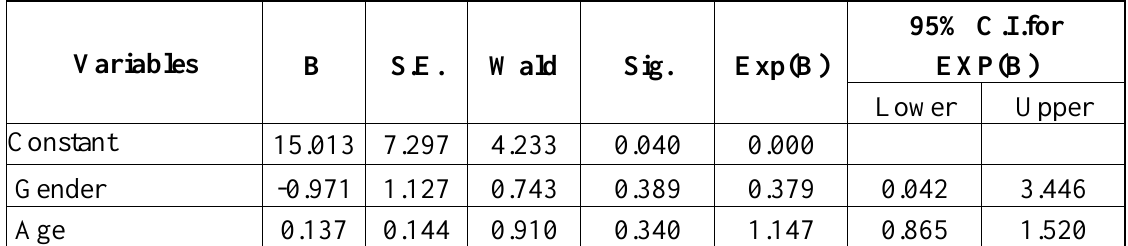
Table 4. The Result of Binary Logistic Regression of the relationship between Socio-economic Characteristics of Respondents and Climate Smart Small Ruminant Production